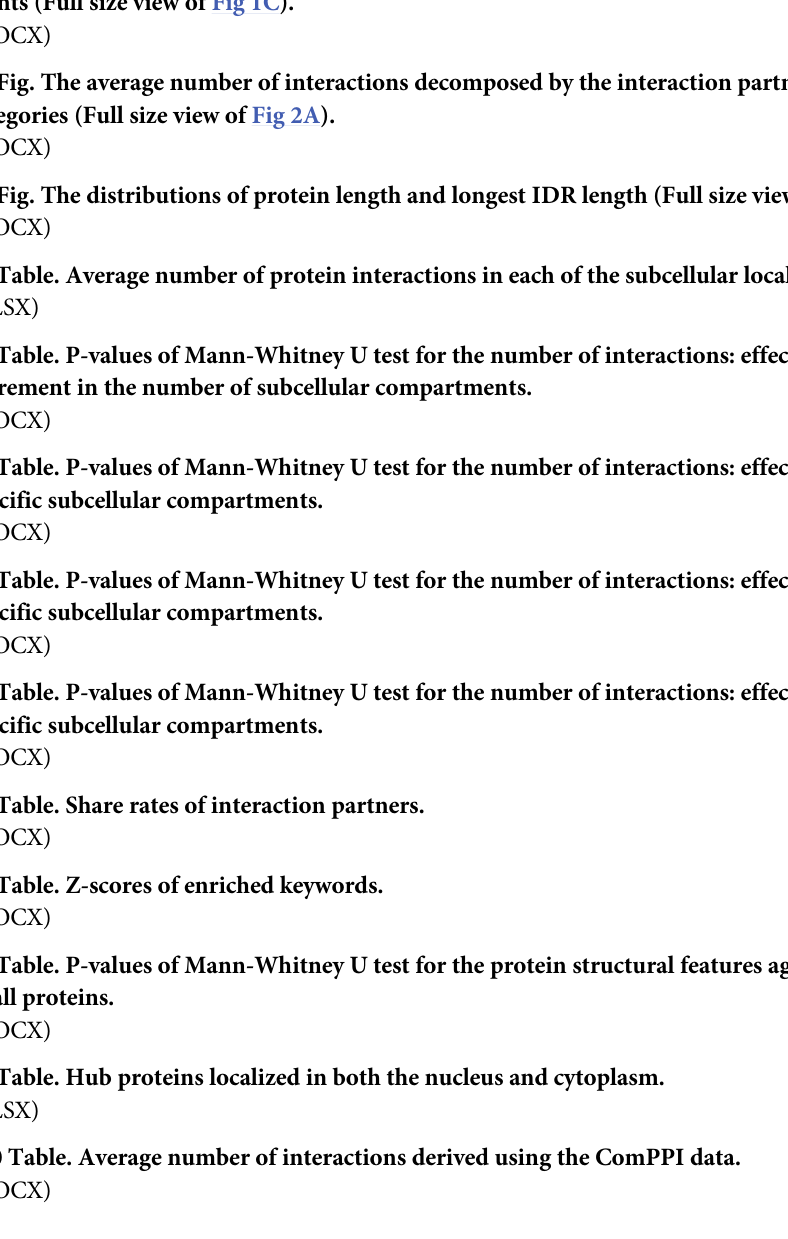
S7 Table. Z-scores of enriched keywords. S8 Table. P-values of Mann-Whitney U test for the protein structural features against